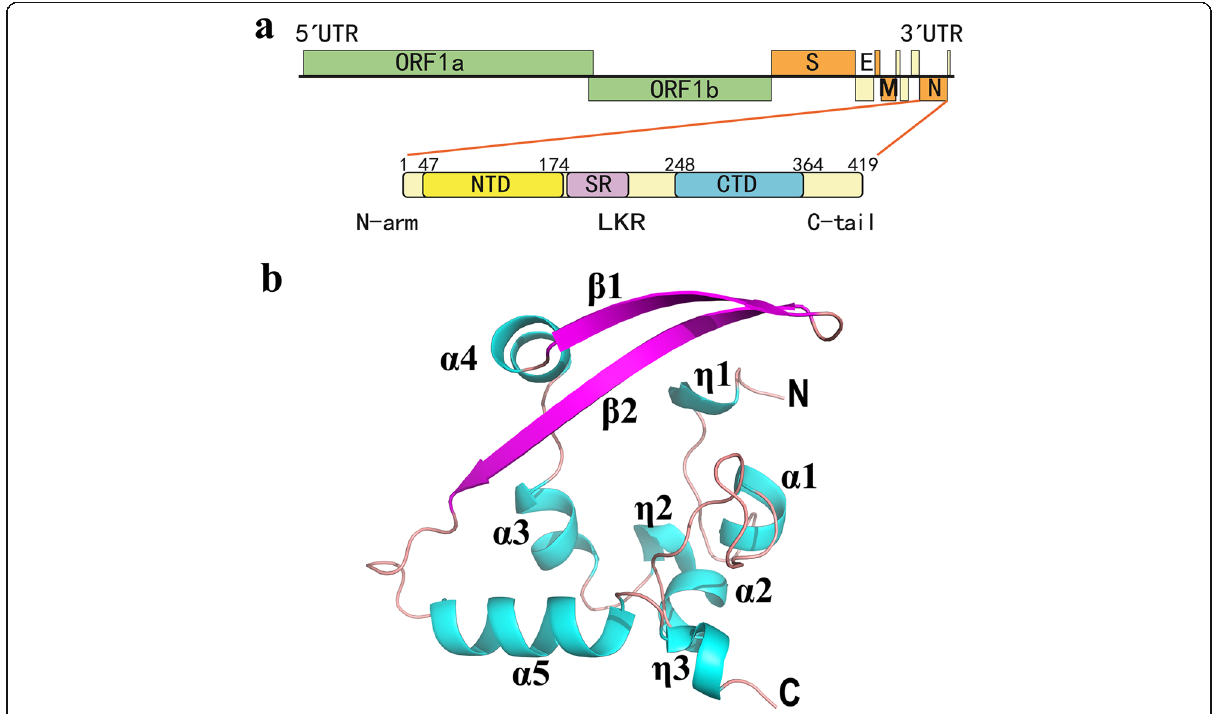
Fig. 1 Overall structure of the SARS-CoV-2 N-CTD. a Genome organization of coronavirus and the domain composition of the SARS-CoV-2 nucleocapsid (N) protein. ORF: open reading frame; S: spike; E: envelope; M: membrane. N protein consists of the N-terminal arm (N-arm), the N- terminal domain (NTD), the central linker region (LKR) within a Ser/Arg (SR) – rich motif, the C-terminal domain (CTD), and the C-terminal tail (C- tail). b Ribbon view of the overall structure of the SARS-CoV-2N-CTD monomer. The structure of N-CTD contains three 3 10 ( η ) helices, five α helices, and two antiparallel β -strands with the order η 1- α 1- α 2- η 2- α 3- α 4- β 1- β 2- α 5- η 3. Helices are shown in cyan, strands in purple. The N and C termini of the N-CTD are marked. Fig. b was prepared with the program PyMOL